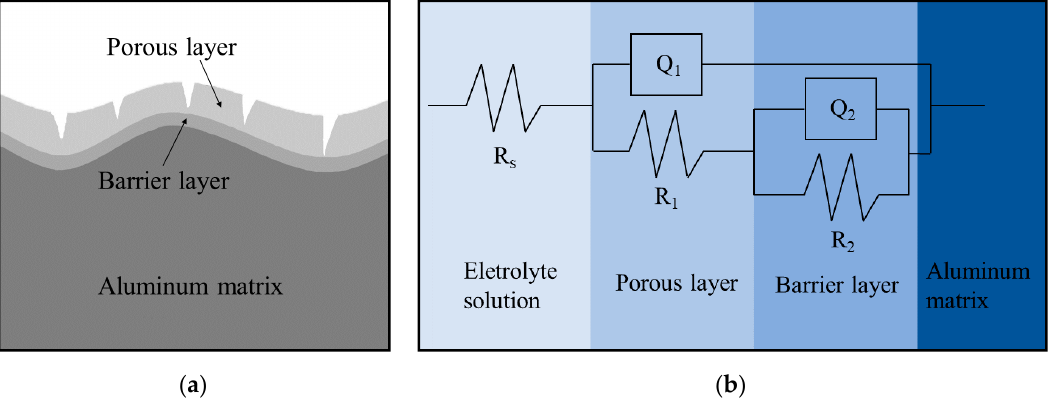
Figure 3. Schematic diagram of: ( a ) surface structure; ( b ) equivalent circuit.